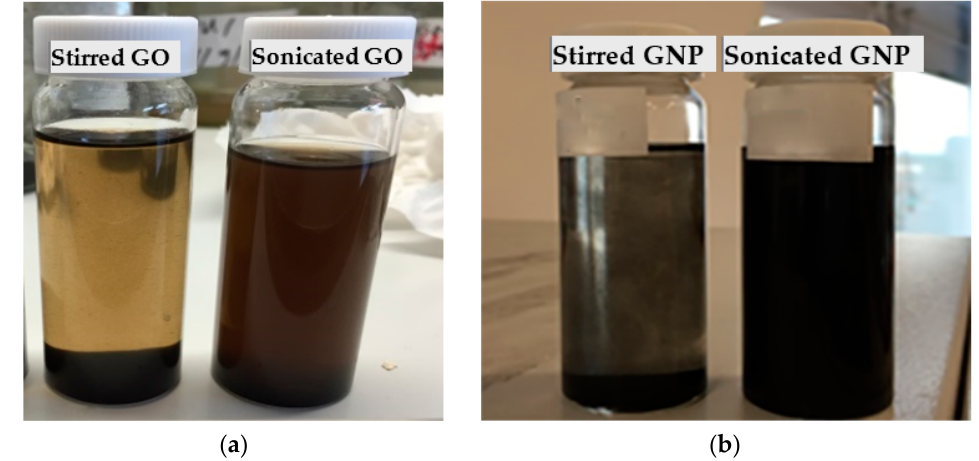
Figure 1. Dispersibility behaviour of GNP and GO in DMAC solvent (0.5 mg/mL) after ultrasonica- tion and magnetic stirring-processes and being left for 24 h: ( a ) GO ( b )